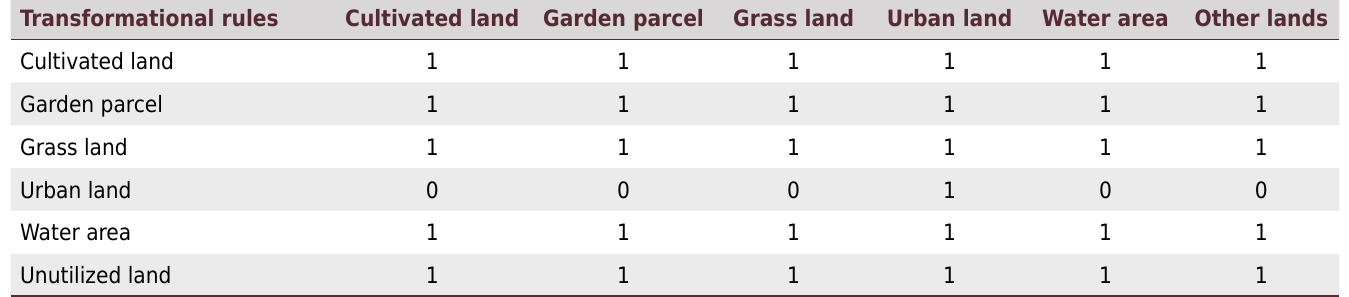
Table 5. Transformational rules among various types of land utilization for the single model Transformational rules Cultivated land Garden parcel Grass land Urban land Water area Other lands